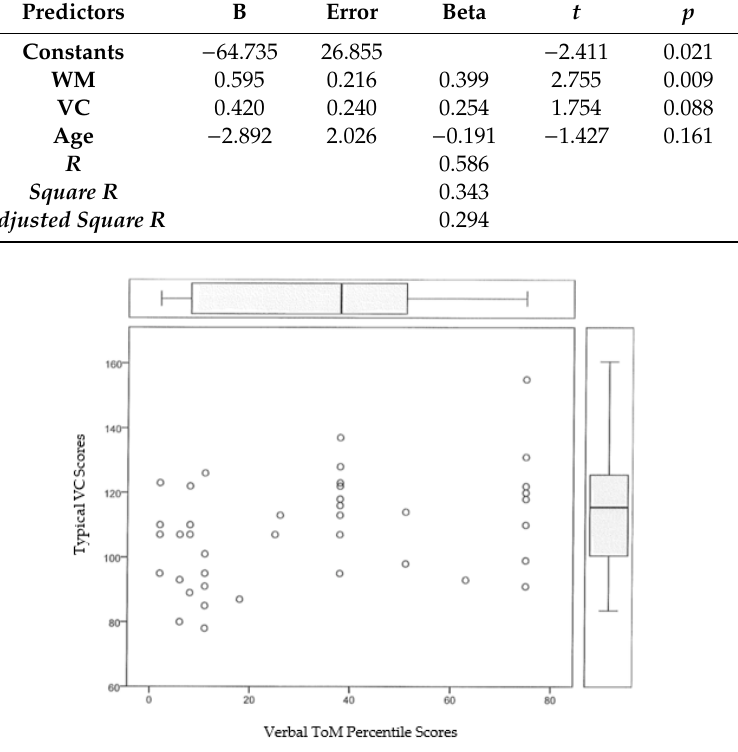
Figure 1. Representation of the effect of the WM on ToM in the model.